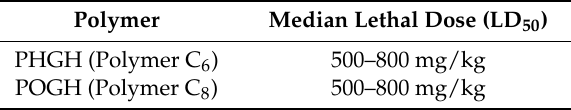
Table 1. Acute toxic effects of PHGH and